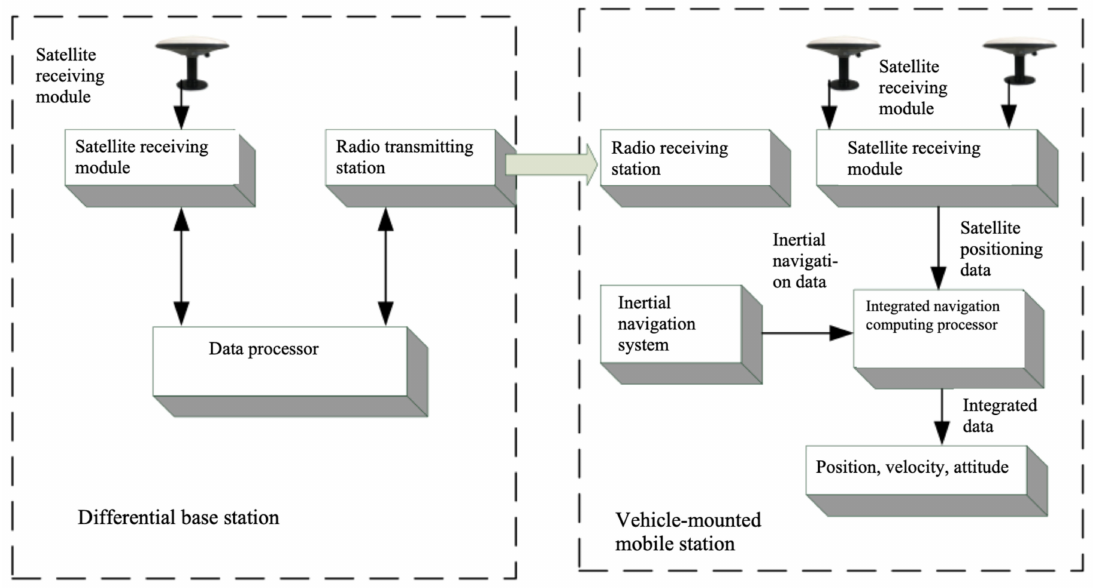
Figure 3. Integrated navigation system